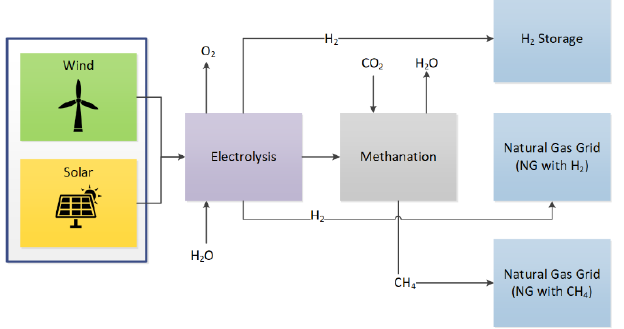
Figure 2. The green hydrogen schematic.